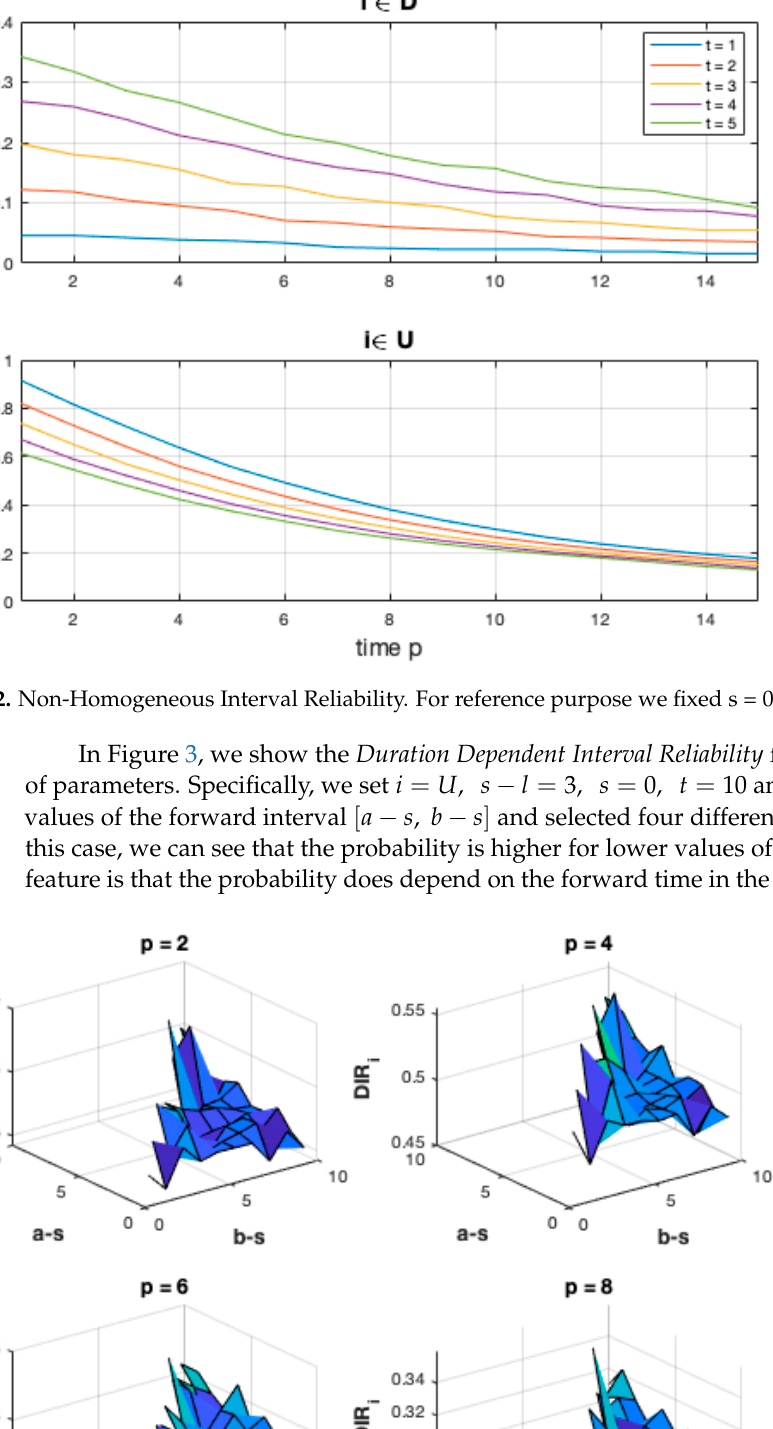
Figure 3. Duration dependent Interval Reliability. In the plots, i = U, s-l = 3, and t = 10. The Duration Dependent Availability of the given window and containing a point is shown in Figure 4 for 𝑖 = 𝑈, 𝑠 = 0, 𝑣 = 3. The function is plotted depending of 𝑥 and 𝜏 . As expected, the probability decreases when the window length 𝜏 increases. We also found a small dependence on 𝑥 . In fact, for small values and for high values of 𝑥 the probability is higher.